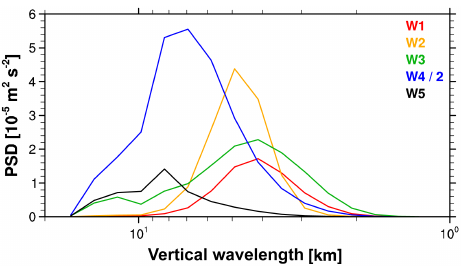
Figure 9. The same as in Fig. 6 except for the vertical-wavelength power spectra of w (cid:48) at z = 8km.